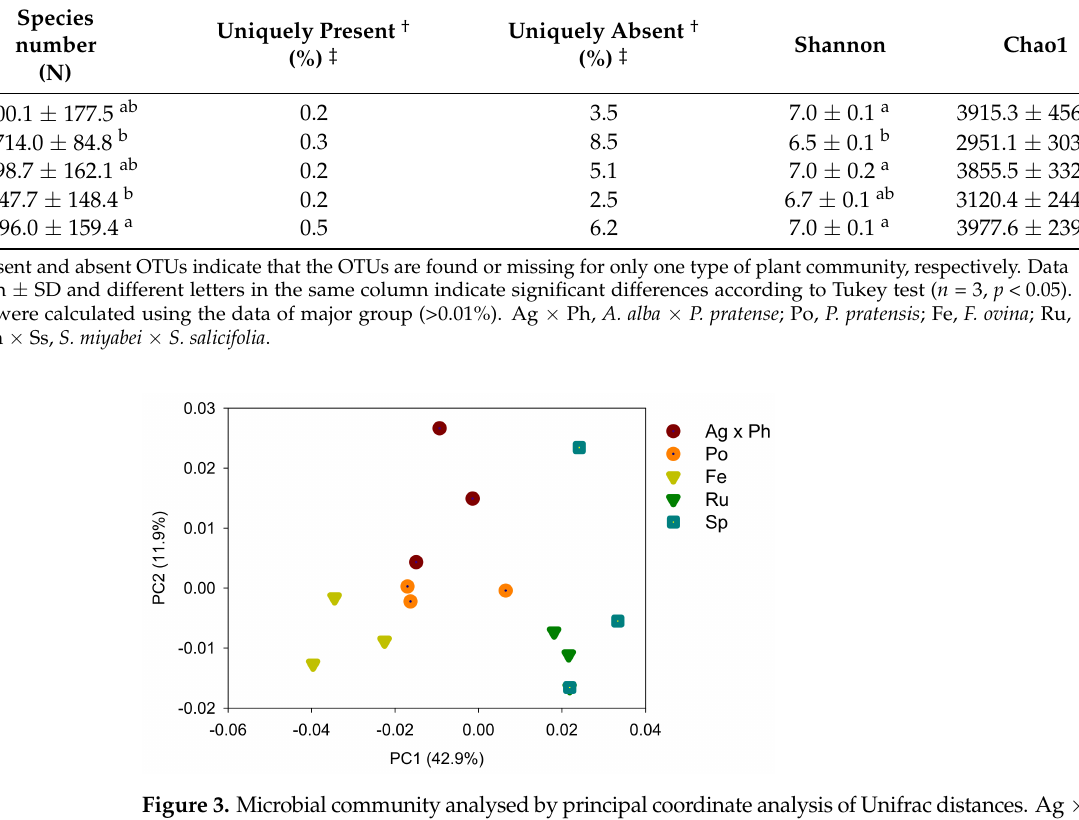
Figure 3. Microbial community analysed by principal coordinate analysis of Unifrac distances. Ag × Ph, A. alba × P. pratense ; Po, P. pratensis ; Fe, F. ovina ; Ru, R. acetosella ; Sm × Ss, S. miyabei × S. salicifolia